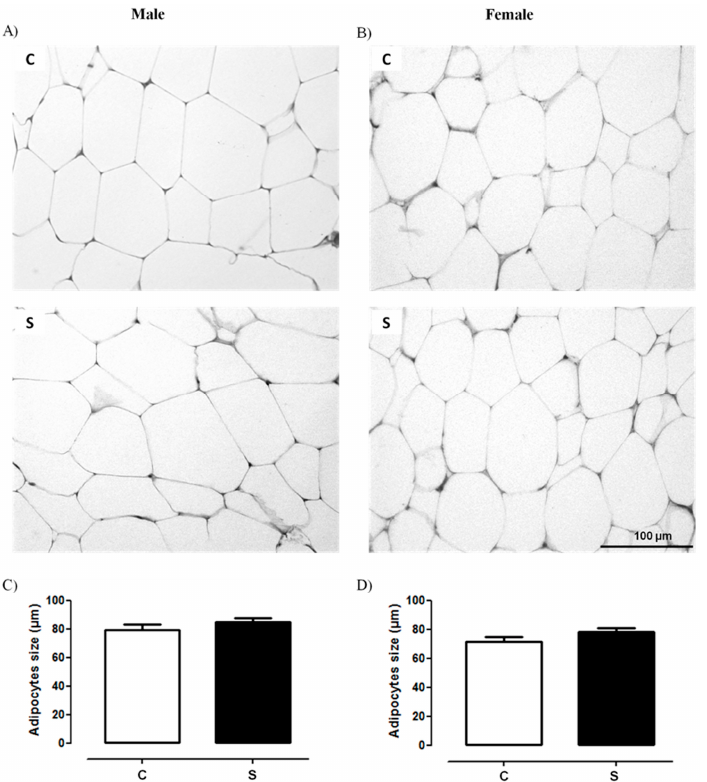
Figure 1. Representative photomicrographs ( × 40; hematoxylin-eosin) of the visceral adipose tissue of adult rats programmed by smoke exposure during the lactation. ( A ) morphology of C and S males; ( B ) morphology of C and S females; ( C ) retroperitoneal adipocyte area size of C and S males; ( D ) retroperitoneal adipocyte area size of C and S females. Both groups showed standard morphology, with no changes in the adipocyte area. Groups: C—CONTROL and S—SMOKE ( n = 6 rats/group). Int. J. Mol. Sci. 2018 , 19 , x FOR PEER REVIEW